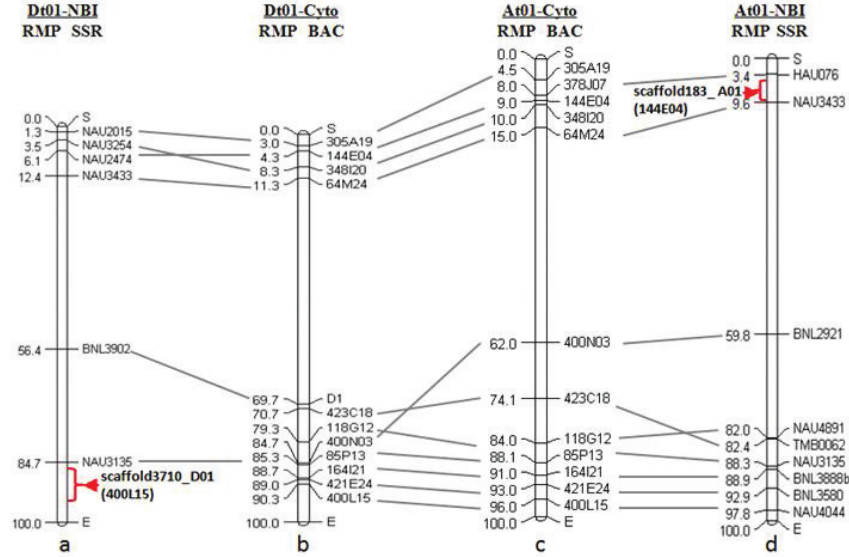
Figure 3. Integrated cytogenetic /genome assembly maps of G. hirsutum A 01/D 01. a Relative map h h position of BACs mapping to D 01 of the AD -NBI draft genome b Cytogenetic map of G. hirsutum h 1 Chromosome D 01 based on 12 BAC clones c Cytogenetic map of G. hirsutum A 01 based on 12 BAC h h clones d Relative map position of BACs mapping to A 01 of the AD -NBI draft genome. Arrow-head in a h 1 and d represent the locations of scaffold3710_D01 and scaffold183_A01 in the draft genome (AD -NBI) 1